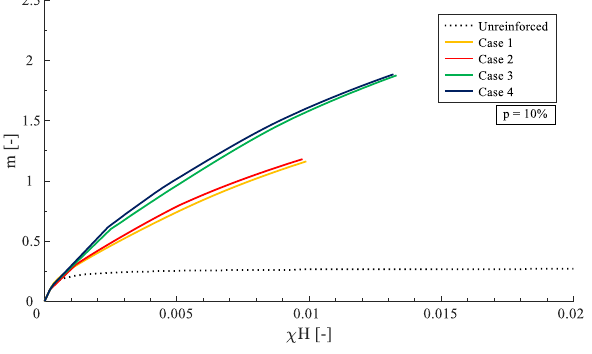
Table 4. Dimensionless parameters, adapted from Papanicolaou et al. [38].